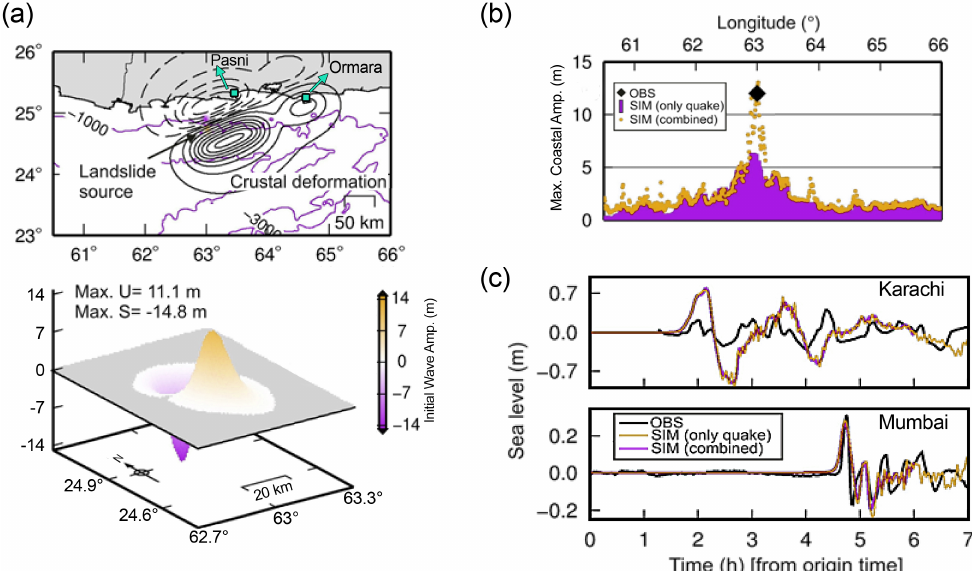
Figure 5. ( a ) The combined earthquake-landslide source proposed by Heidarzadeh and Satake [38] for the 1945 Makran tsunami. Their landslide source has an identical length and width of 15 km and a thickness of 600 m. ( b ) The resultant maximum coastal amplitude from the combined source [38] ( c ) Comparison between the observed and simulated waveforms at Karachi and Mumbai [38]. OBS observed, SIM simulated, U uplift, S subsidence. Modified after Heidarzadeh and Satake